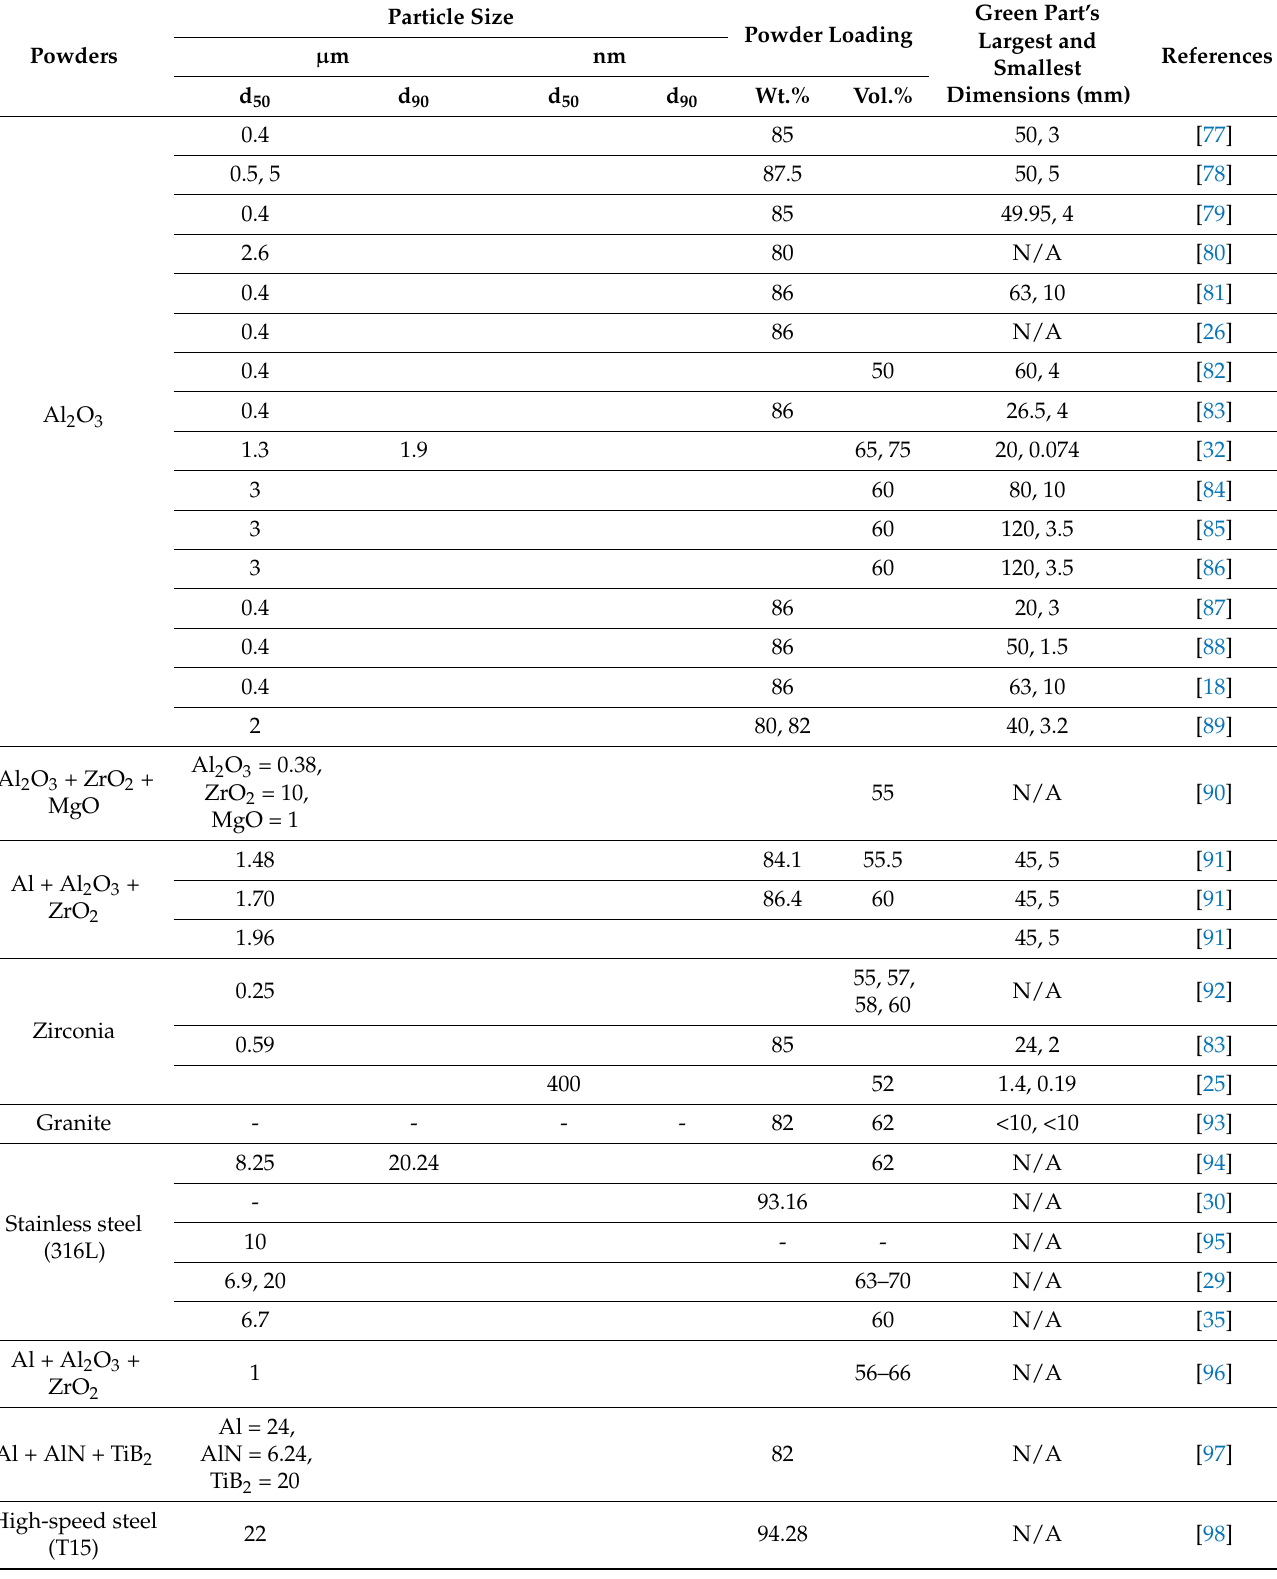
Table 1. Powders and characteristics of the powders used in the LPIM